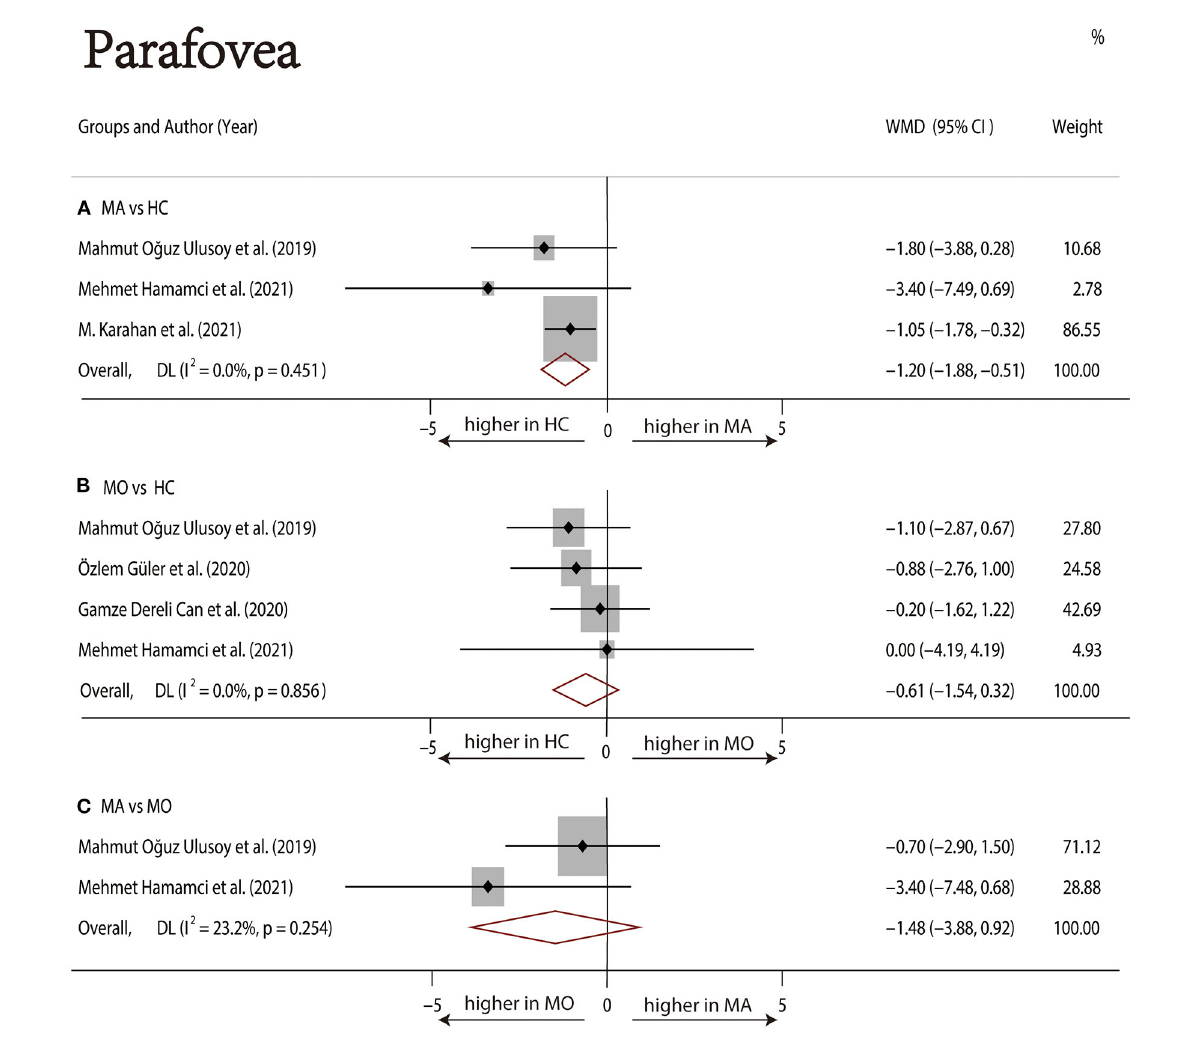
FIGURE8 Forest plot of WMD of the parafoveal DCP VD. (A) Parafoveal VD comparison of MA and HC; (B) parafoveal VD comparison of MO and HC; (C) parafoveal VD comparison of MA and